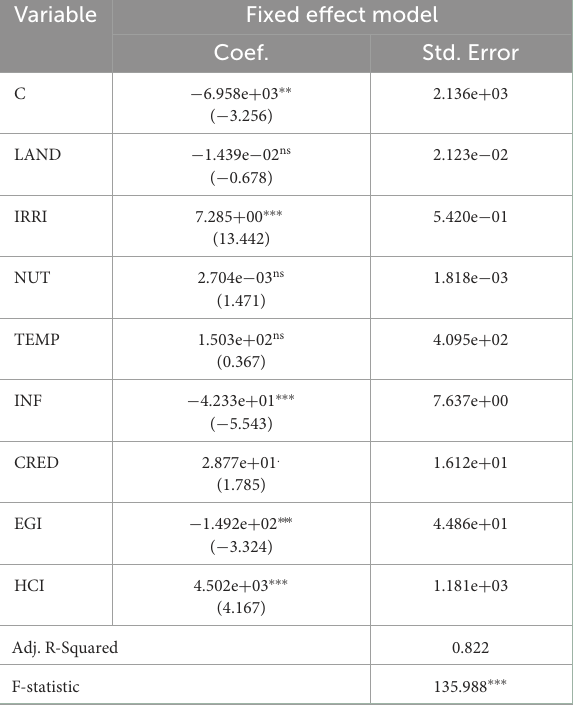
TABLE 4 Fixed effect model of the impact of EG on AVA in the MENA region.